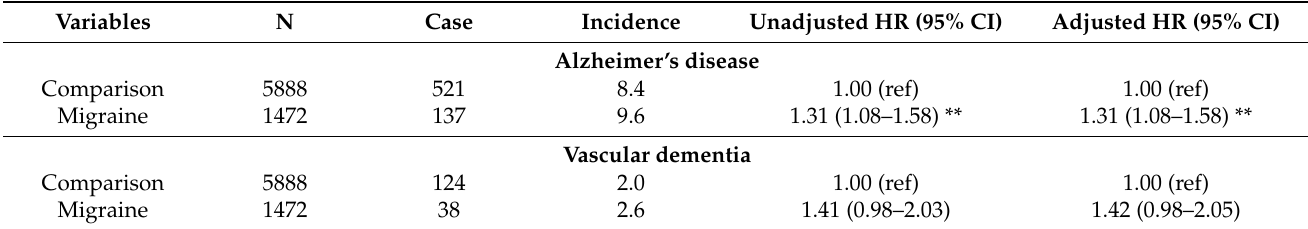
Table 6. Incidence per 1000 person-years and HR (95% CI) of specific diseases (Alzheimer’s disease and vascular